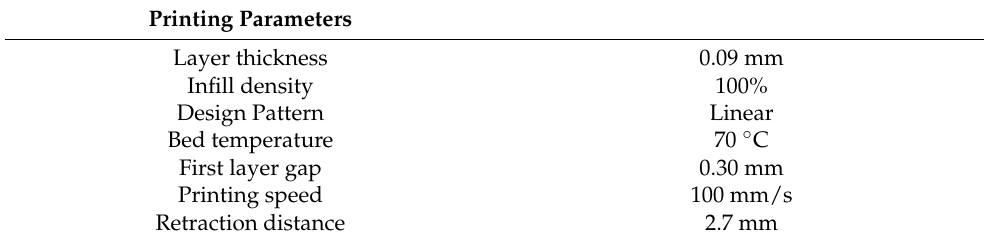
Table 2. Processing conditions to 3D